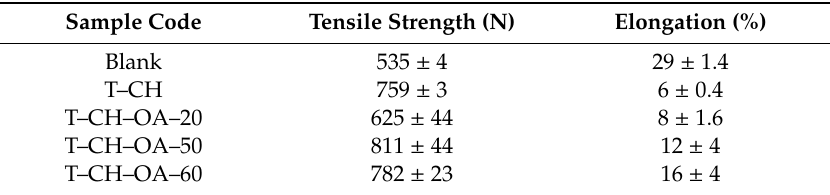
Table 4. Mechanical properties of uncoated and coated textile